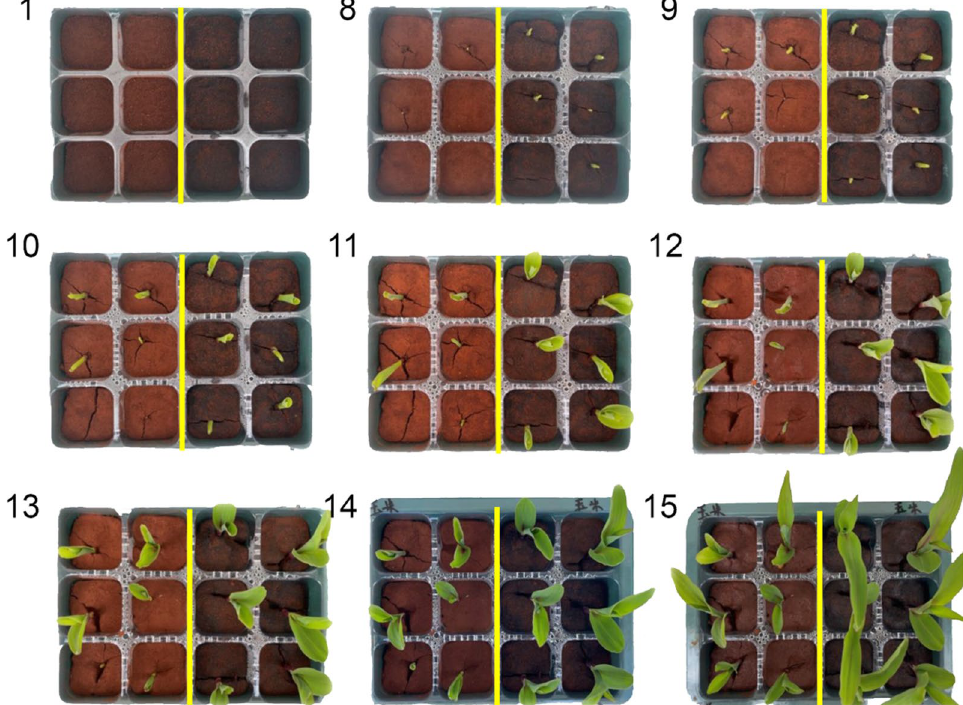
Fig. 8 The growth trend of maize seeds in pure soil sample (two columns on the left) and soil sample mixed with MSBL3